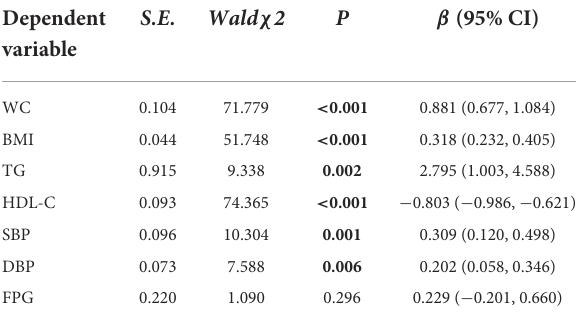
TABLE 4 Association between DII and various MetS related biochemical indicators.